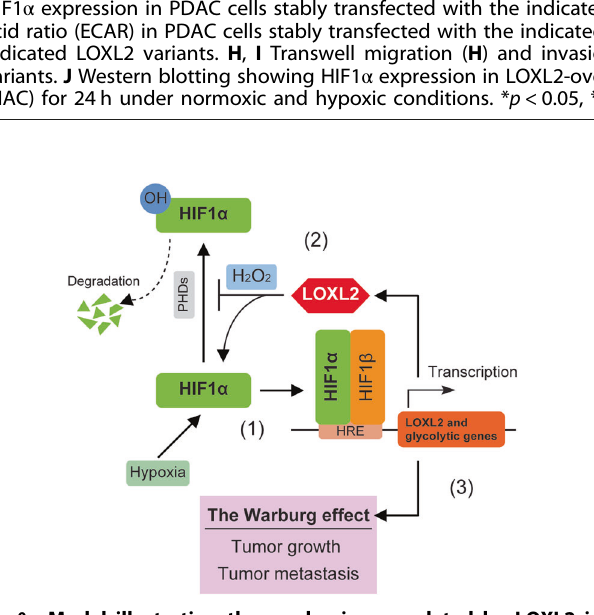
Fig. 8 The catalytic activity is responsible for the oncogenic roles of LOXL2. A Schematic representation of wild-type LOXL2, deletion mutant ( Δ LOXL2), and double point mutant (H626Q/H628Q) with the HA-tag. B Western blotting showing the indicated LOXL2 variants stably expressed in PDAC cells using anti-LOXL2 and anti-HA antibodies. C Intracellular hydrogen peroxide measured in PDAC cells stably transfected with the indicated LOXL2 variants. D Western blotting showing hydroxylated HIF1 α (HIF1 α -OH) expression in PDAC cells stably transfected with the indicated LOXL2 variants treated with 10 μ M MG132 for 6 h under normoxic and hypoxic conditions. E Western blotting showing HIF1 α expression in PDAC cells stably transfected with the indicated LOXL2 variants under normoxic and hypoxic conditions. F Extracellular acid ratio (ECAR) in PDAC cells stably transfected with the indicated LOXL2 variants. G CCK-8 assay of PDAC cells stably transfected with the indicated LOXL2 variants. H , I Transwell migration ( H ) and invasion ( I ) assays of PDAC cells stably transfected with the indicated LOXL2